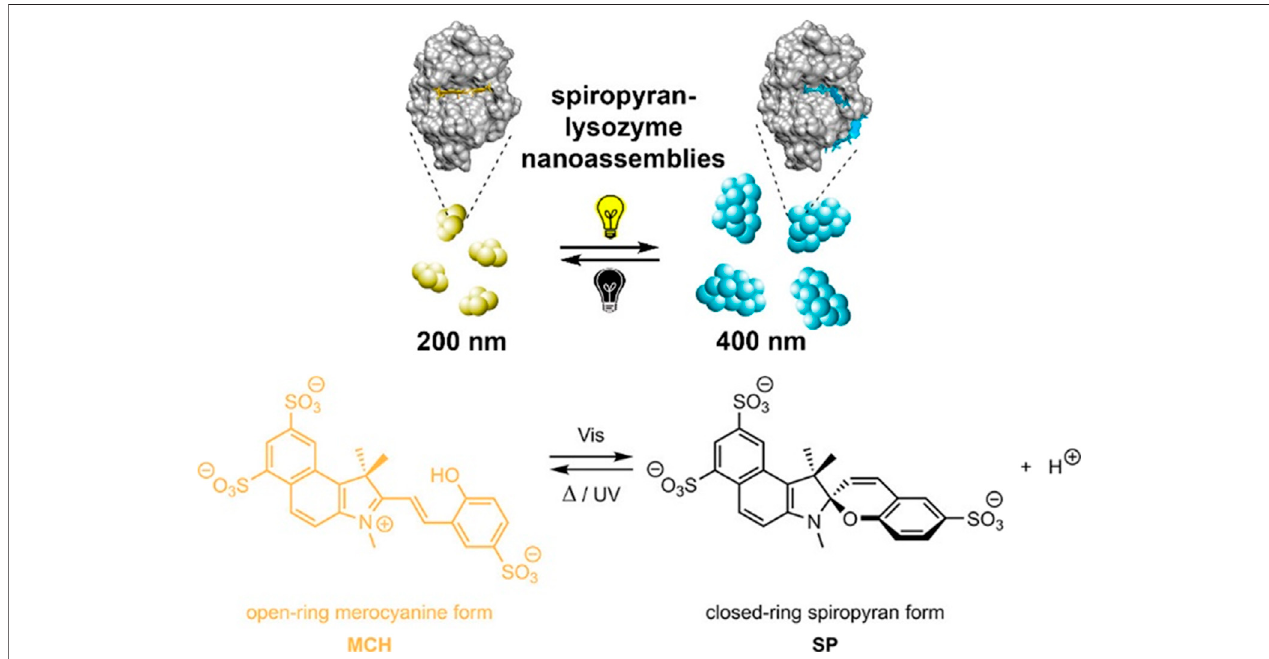
FIGURE 23 | Light-triggerable enzyme aggregation and activity; top: Schematic representation of the assemblies of an ionic spiropyrane and lysozyme; bottom: Interconversion of the two spiropyran isomers in inverse photochromism (Moldenhauer et al., 2019). Reprinted with permission. Copyright © 2018 American Chemical